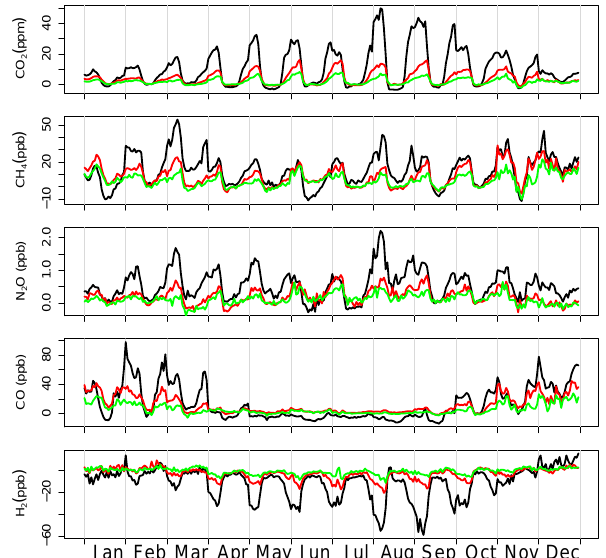
Figure 8. Vertical gradient of the mean diurnal cycles between the 5 and 180m sampling level (black), the 50 and 180m sampling level (red) and the 100 and 180m sampling level (green) for CO 2 , CH 4 , N 2 O, CO and H 2